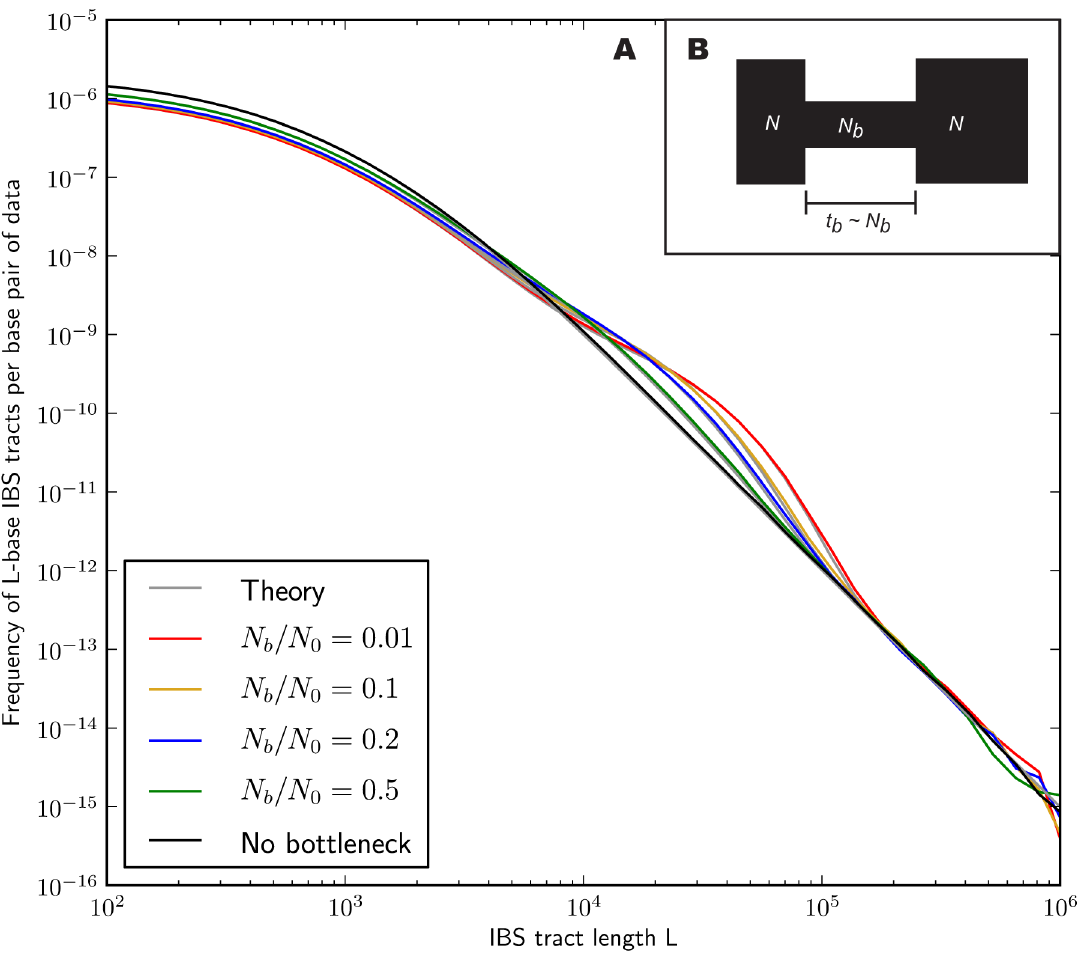
Figure 3. Shared IBS tracts within bottlenecked populations. As in Figure 2, each colored spectrum in Figure 3A was generated by using MS to simulate 4 : 8 | 10 10 base pairs of pairwise alignment. Both sequences are derived from the population depicted in Figure 3B that underwent a bottleneck from size N 0 ~ 10,000 to size N b , the duration of the bottleneck being N b = 2 generations. 1,000 generations ago, the population recovered to size 10,000. These bottlenecks leave similar frequencies of very long and very short IBS tracts because they have identical ratios of strength to duration, but they leave different signature increases compared to the no-bottleneck history in the abundance of 10 4 – 10 5 -base IBS tracts. In grey are the expected IBS tract spectra that we predict analytically for each simulated